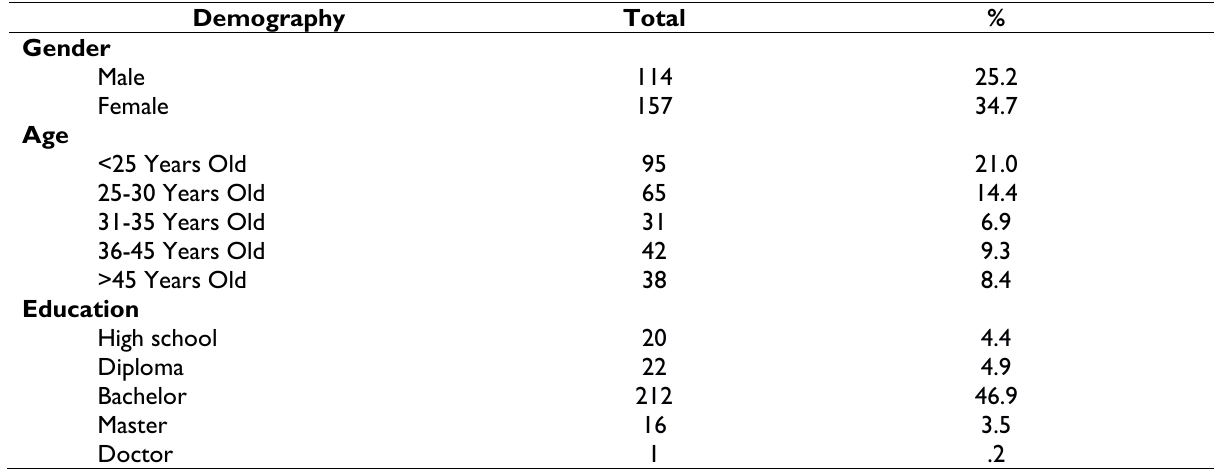
Table 1. Characteristics of